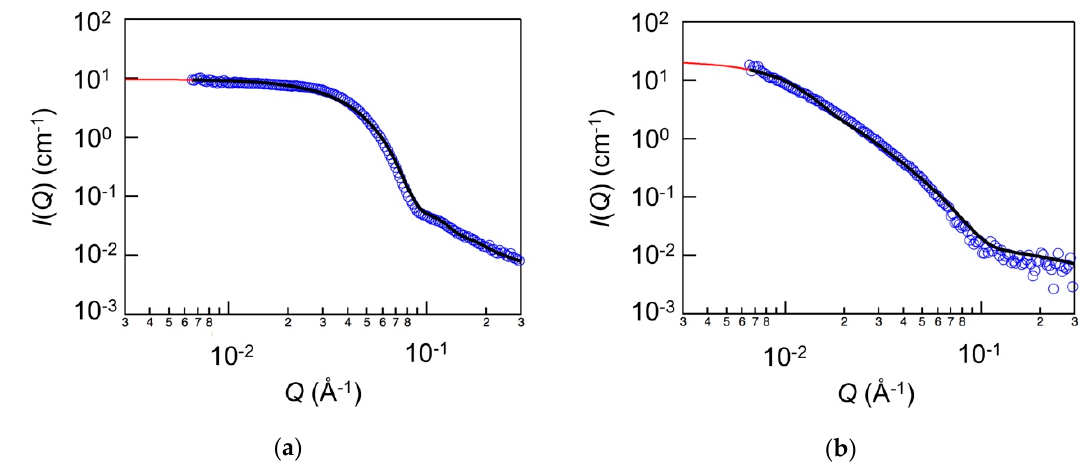
Figure 8. SANS profiles of PEG- b -PLGA ( a ) in single-body solution and ( b ) in the laponite/PEG- b -PLGA nanocomposite. The solid line in the figure represents the fitting curve with Equations (3), (5), and (6).